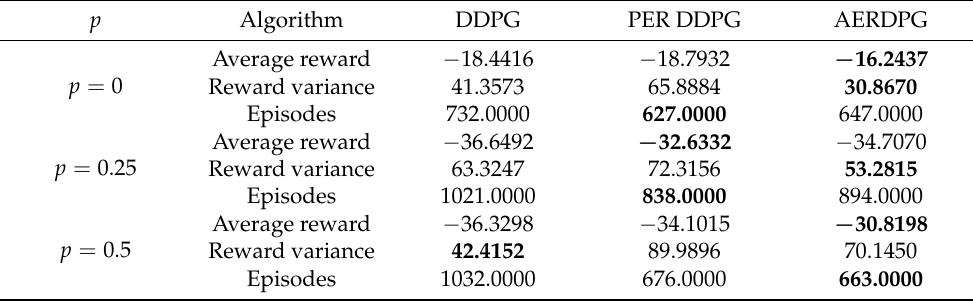
Table 2. A comparison of experimental results of total reward value. p Algorithm DDPG PER